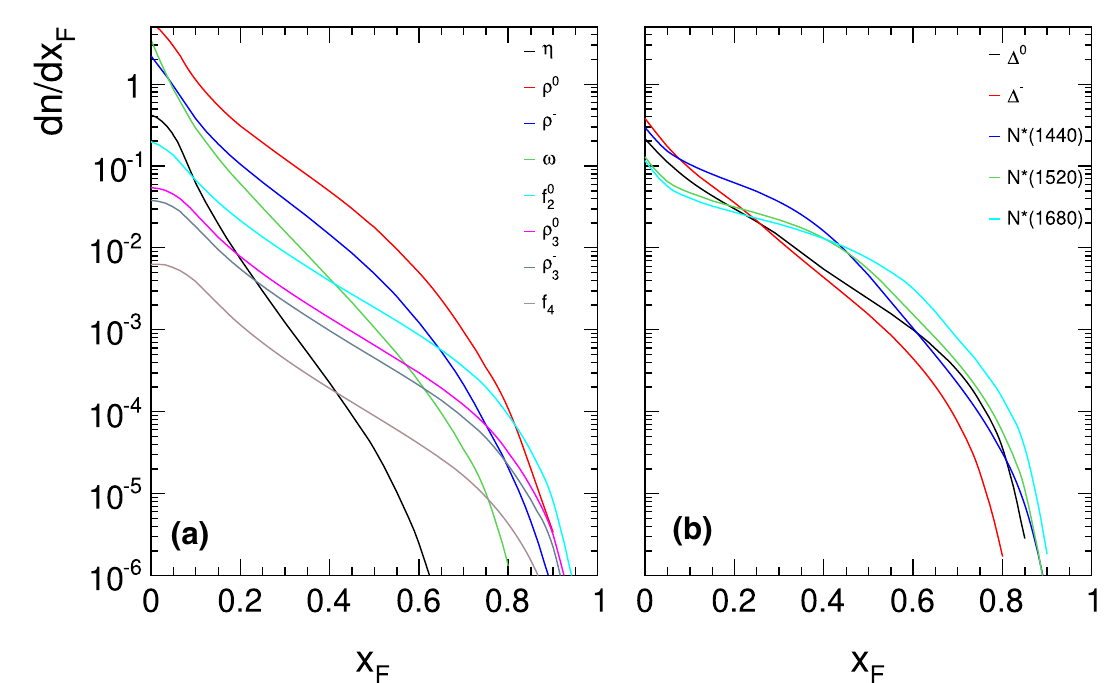
Fig. 195 dn / dx F distributions for π − from the decay of the resonances used in Table 9 as a function of x